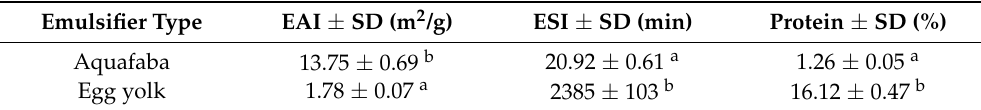
Table 2. Emulsifying activity index (EAI), emulsion stability index (ESI), and protein content in aquafaba and egg